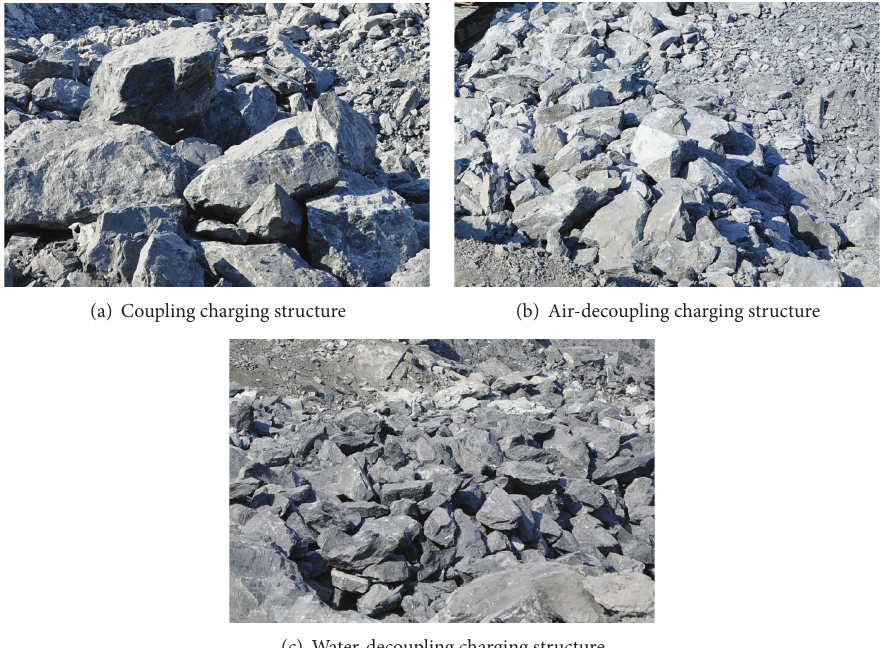
Figure 6: The effect diagram of blasting of different charge